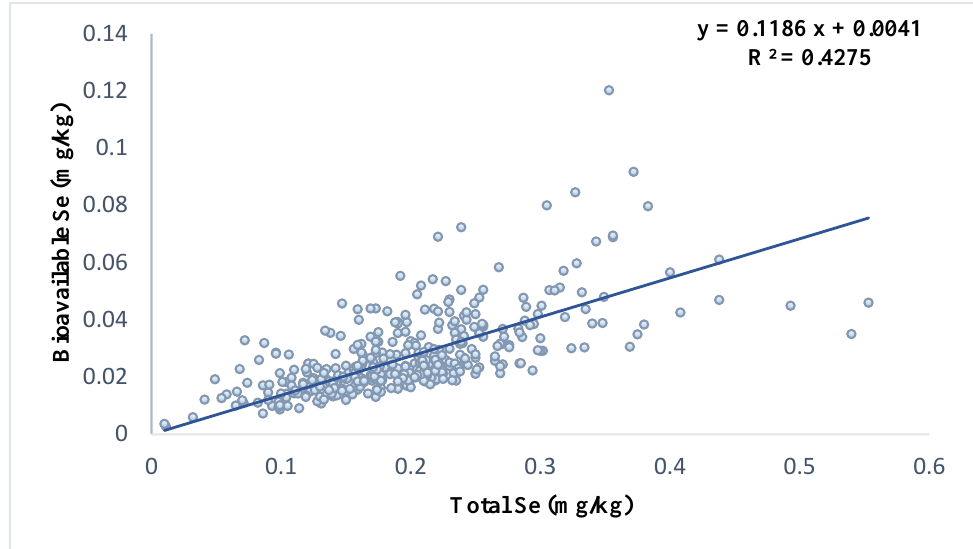
Figure 2. Se distribution in alkaline arable soils of Zhongwei: ( a ) total Se content and classification according to Tan (1989), ( b ) bioavailable Se, ( c ) percentage of bioavailable selenium.